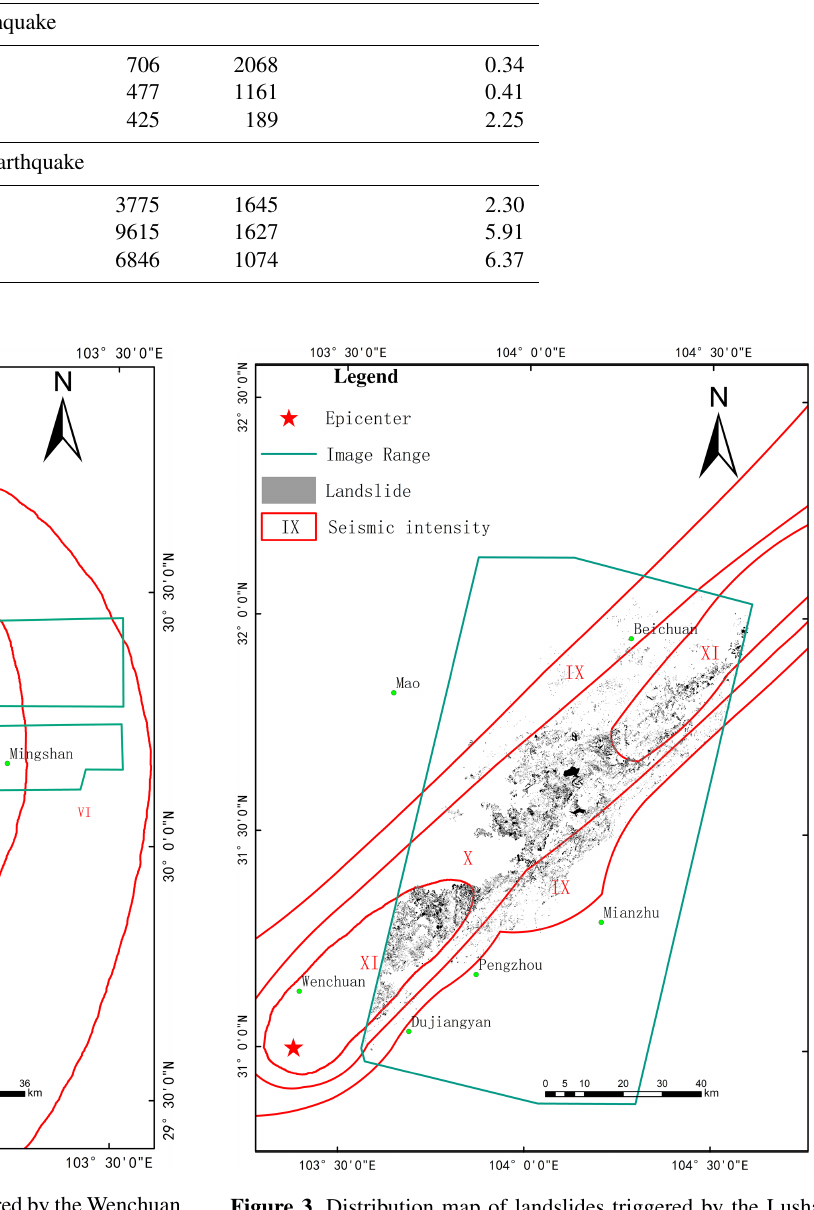
Figure 3. Distribution map of landslides triggered by the Lushan